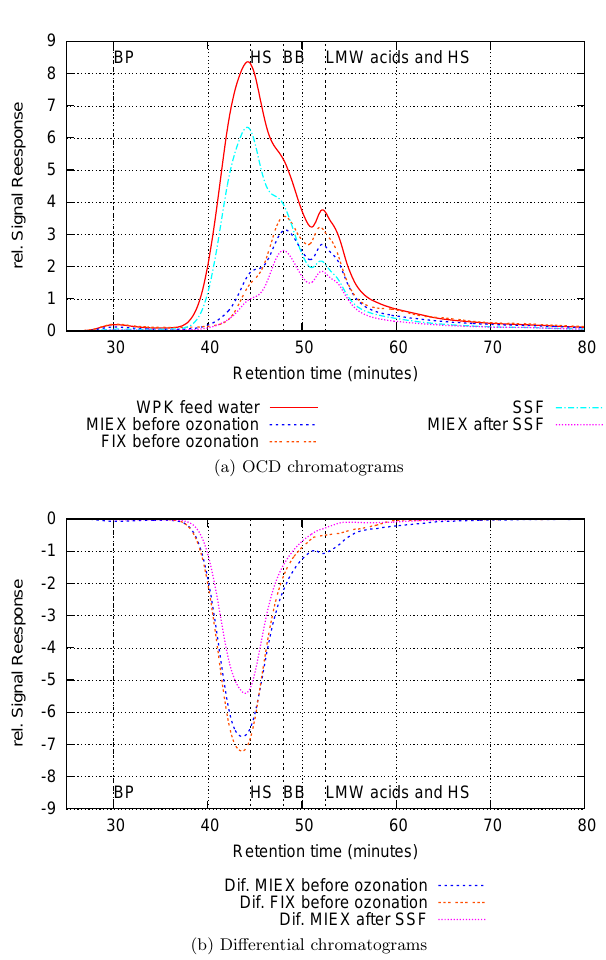
Figure 2: LC-OCD (differential) chromatograms of the different water qual- Figure 2. LC-OCD (di ff erential) chromatograms of the di ff erent ities water qualities.